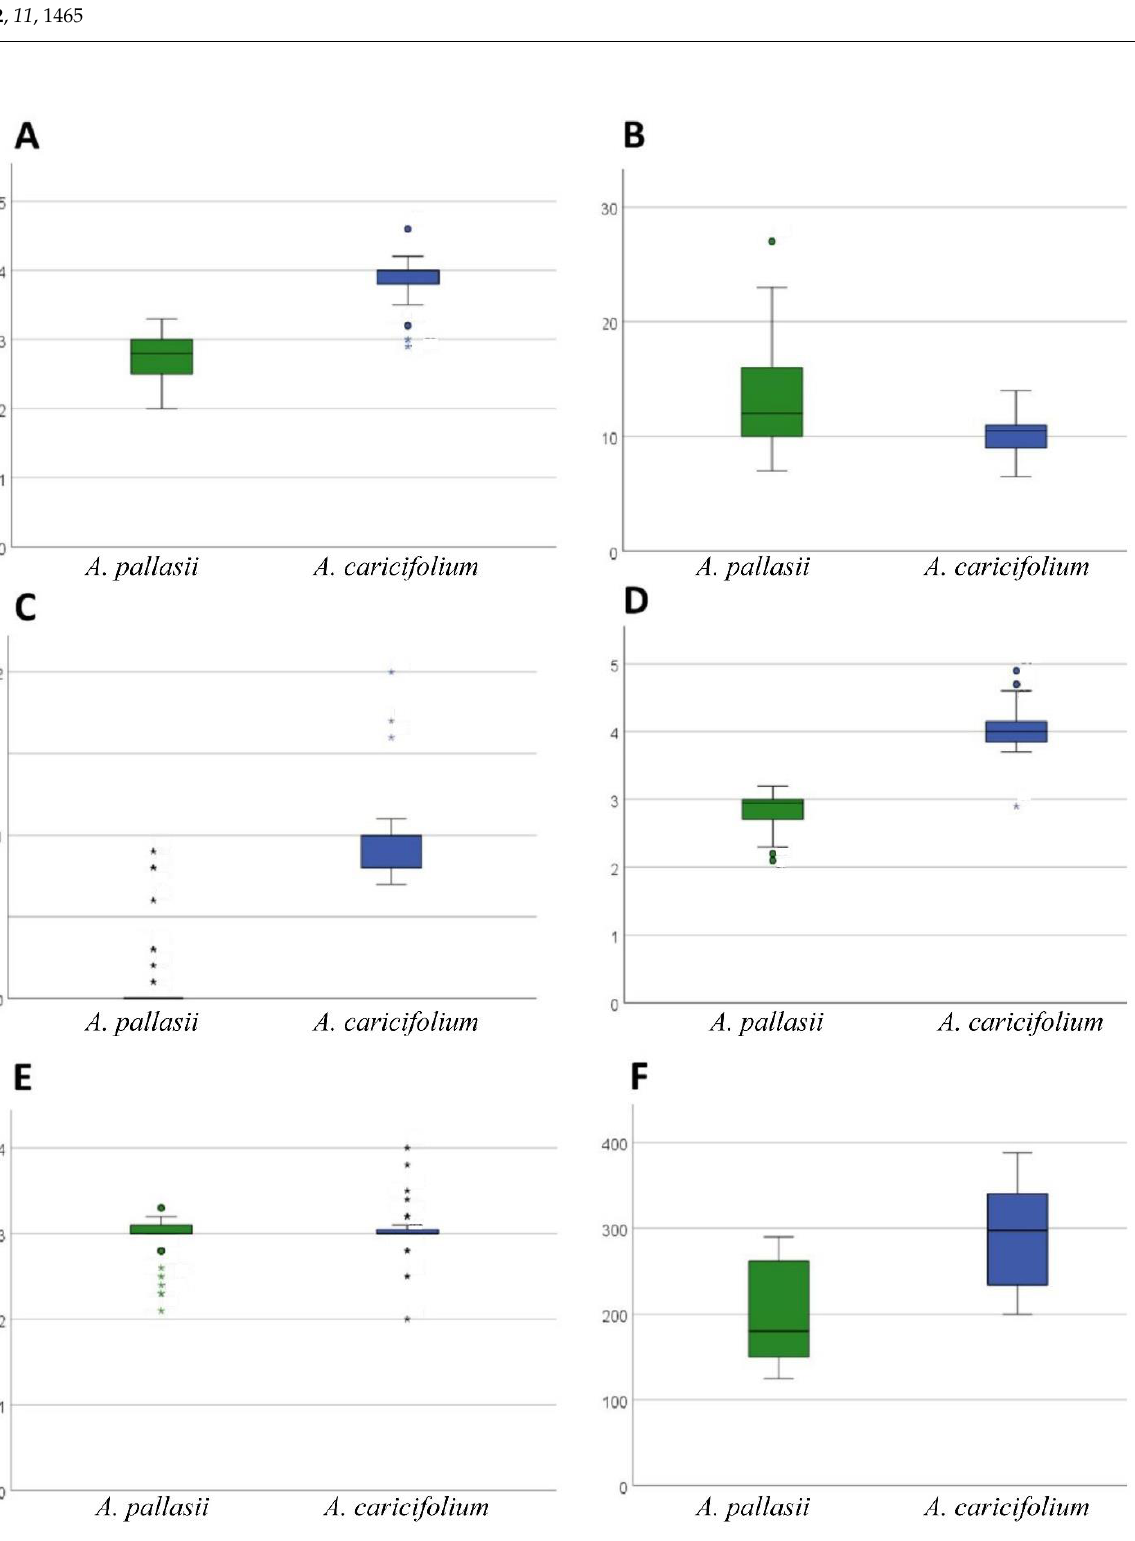
Figure 2. Boxplot analysis of different morphological character (in mm). ( A ): Carpel length, ( B ): Pedicel length, ( C ): Length of filaments outside tepals, ( D ): Filaments length in total, ( E ): Tepal length, ( F ): Scape length. The sizes range between 0 – 30 mm ( A – E ), the scape length is between 0 and 400 mm ( F ). A. pallasii is shown in green, A. caricifolium in blue.